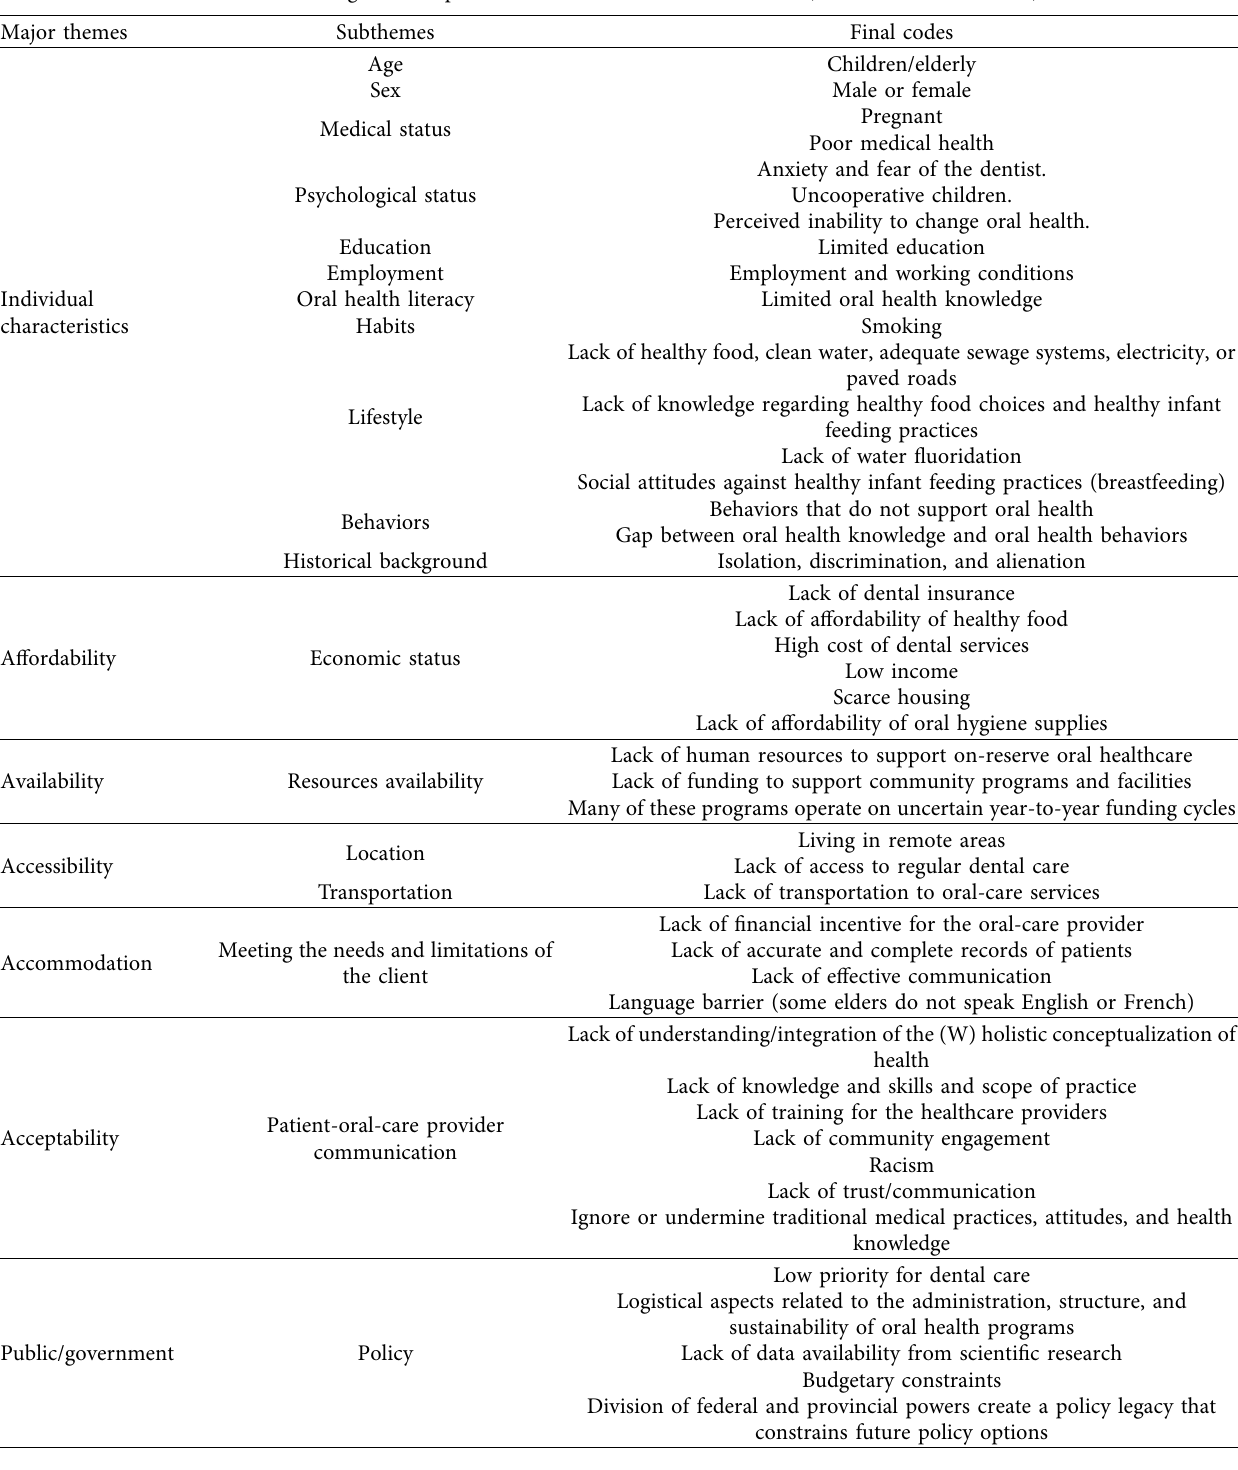
Table 3: Challenges to the provision/utilization of oral healthcare (modified CAHS